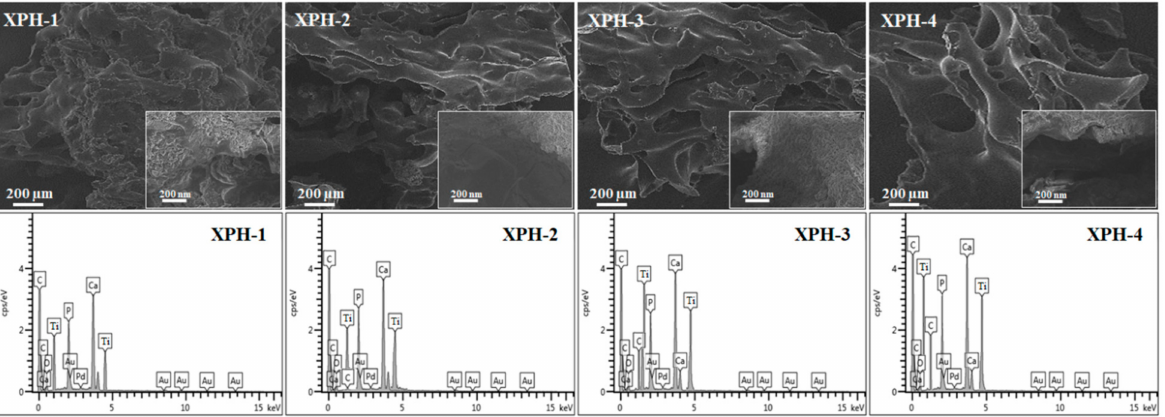
Figure 3. SEM micrographs of the surface of the samples. The inset micrographs show the zoom-in surface of the scaffold samples. The graphs show the EDX spectra of the hybrid nanocomposite